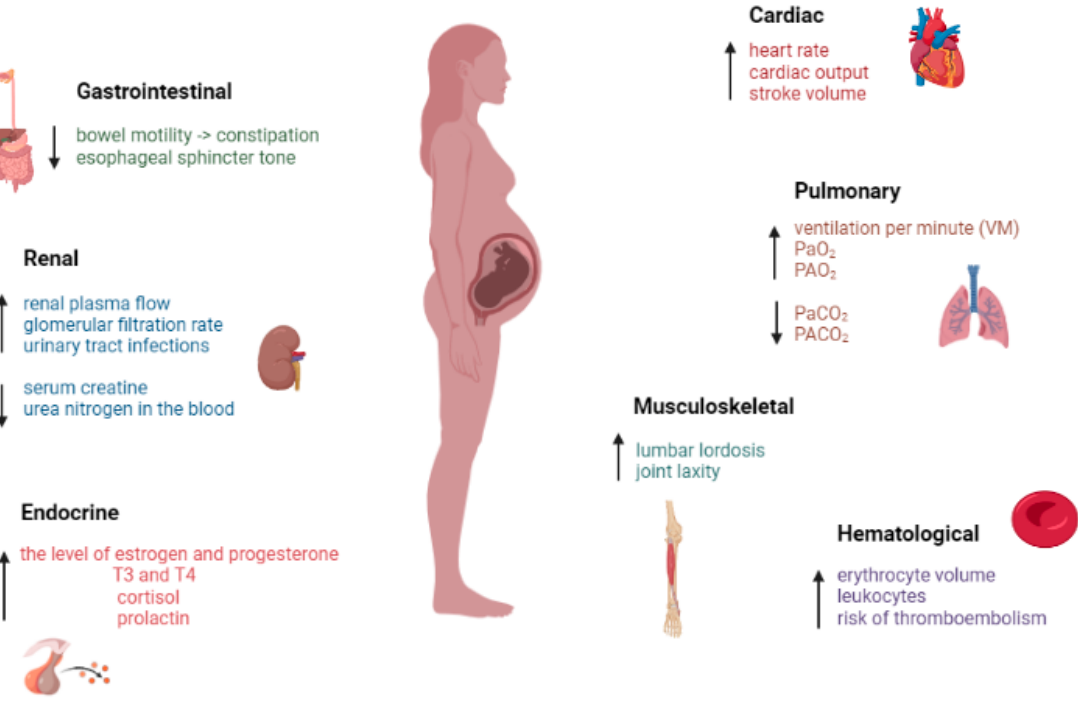
Figure 1. The main physiological and anatomical changes of pregnancy. ( ↑ —increase, ↓ —de- crease)